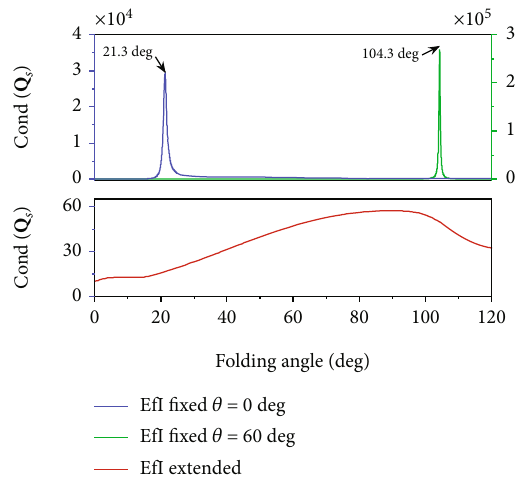
Figure 15: Determinant of the information matrix varying with the folding angle under di ff erent sensor layouts.